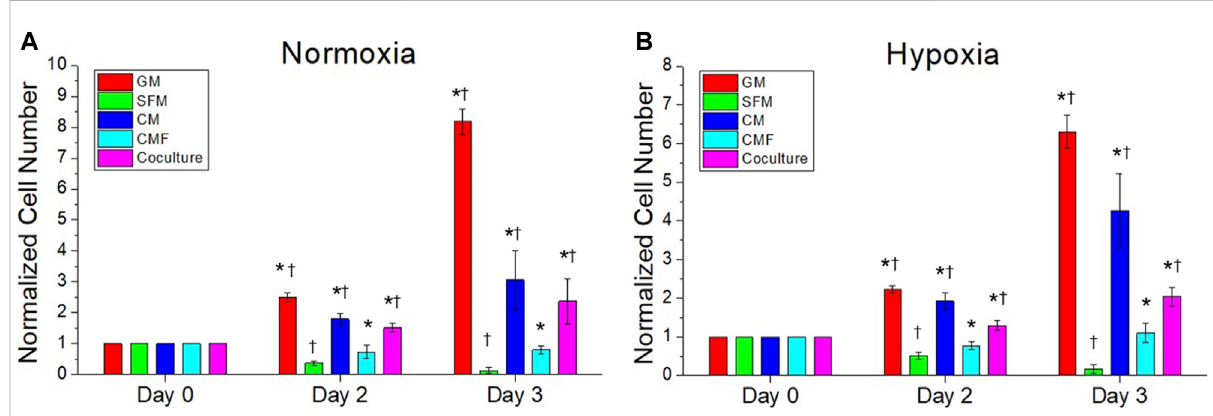
FIGURE 8 Theef fi cacyofCMFcomparedwithCMandhPSCco-cultureonhumanumbilicalveinendothelialcell(HUVEC)growth.HUVECsareculturedin normoxia (A) and hypoxia (B) with HUVEC-GM, HUVEC-SFM, hPSC-CM 6×, CMF 6×, and hPSC-HUVEC co-culture. Cell number is calculated using AlamarBlue assay and normalized to the cell number at day 0. HUVEC number treated with CMF is signi fi cantly higher than SFM but lower than CM and co-culture ( n = 4, duplicate measure, two-way ANOVA and Tukey ’ s test, * p < 0.05 with SFM, † p < 0.05 with